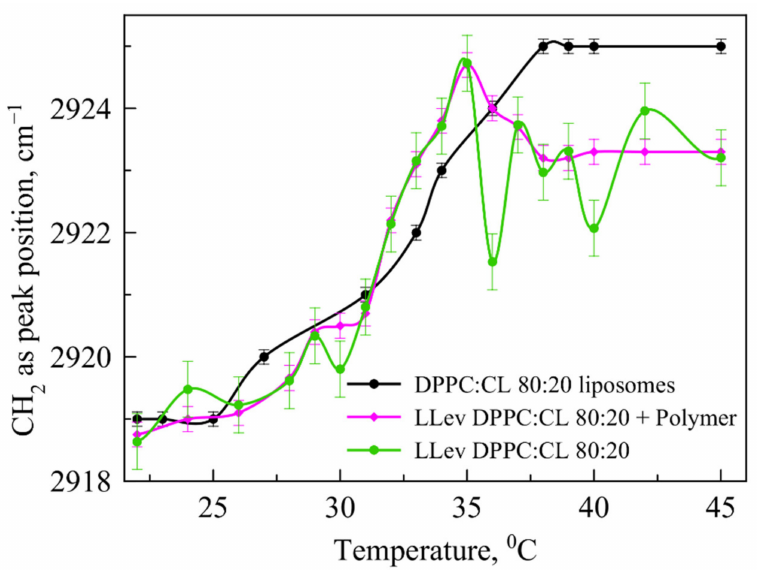
Figure 4. Dependence of ν CH2 as the peak position on the temperature for DPPC:CL 80:20 liposomes (black line), LLev DPPC:CL (green line) and complex LLev DPPC:CL with mannosylated chitosan (ChitMan) (magenta line). For each point, the SD ( n = 3) is presented. Total lipid concentration 5 mg/mL, 0.02 M PBS pH 7.4.